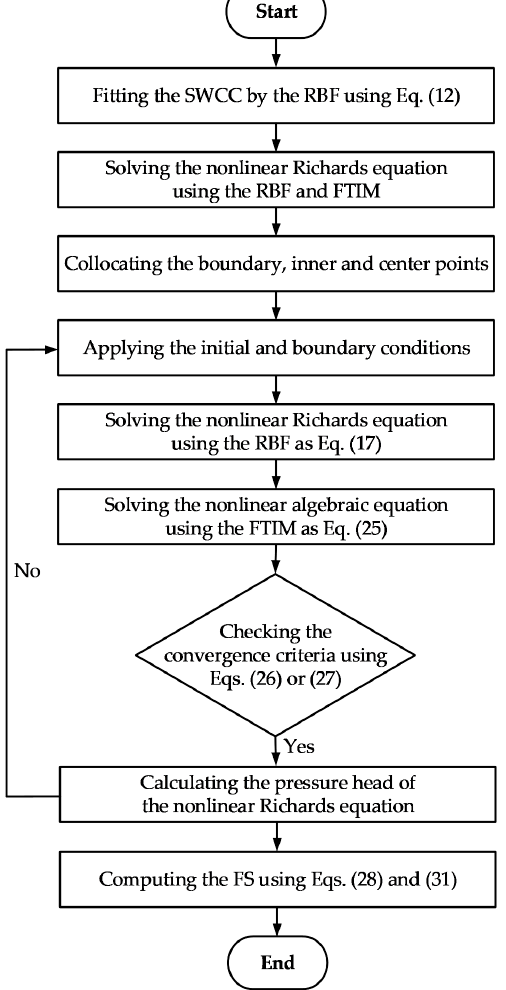
Figure 3. The flowchart of this study.